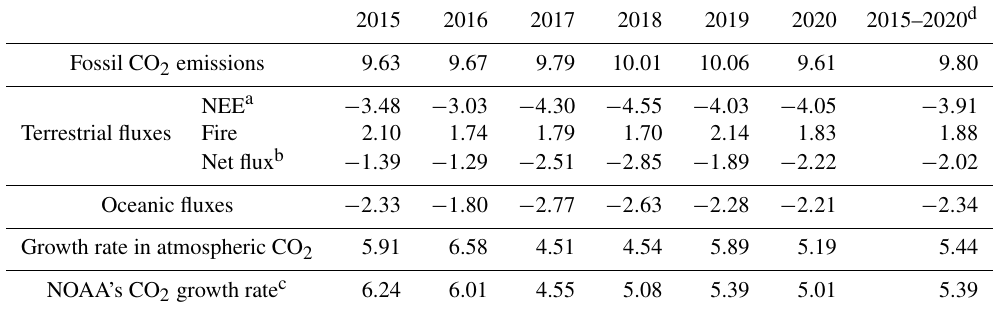
Table 3. Global anthropogenic CO 2 budget from 2015–2020 derived from our reference inversion results and NOAA’s atmospheric CO 2 growth rate. All values are in GtCyr − 1